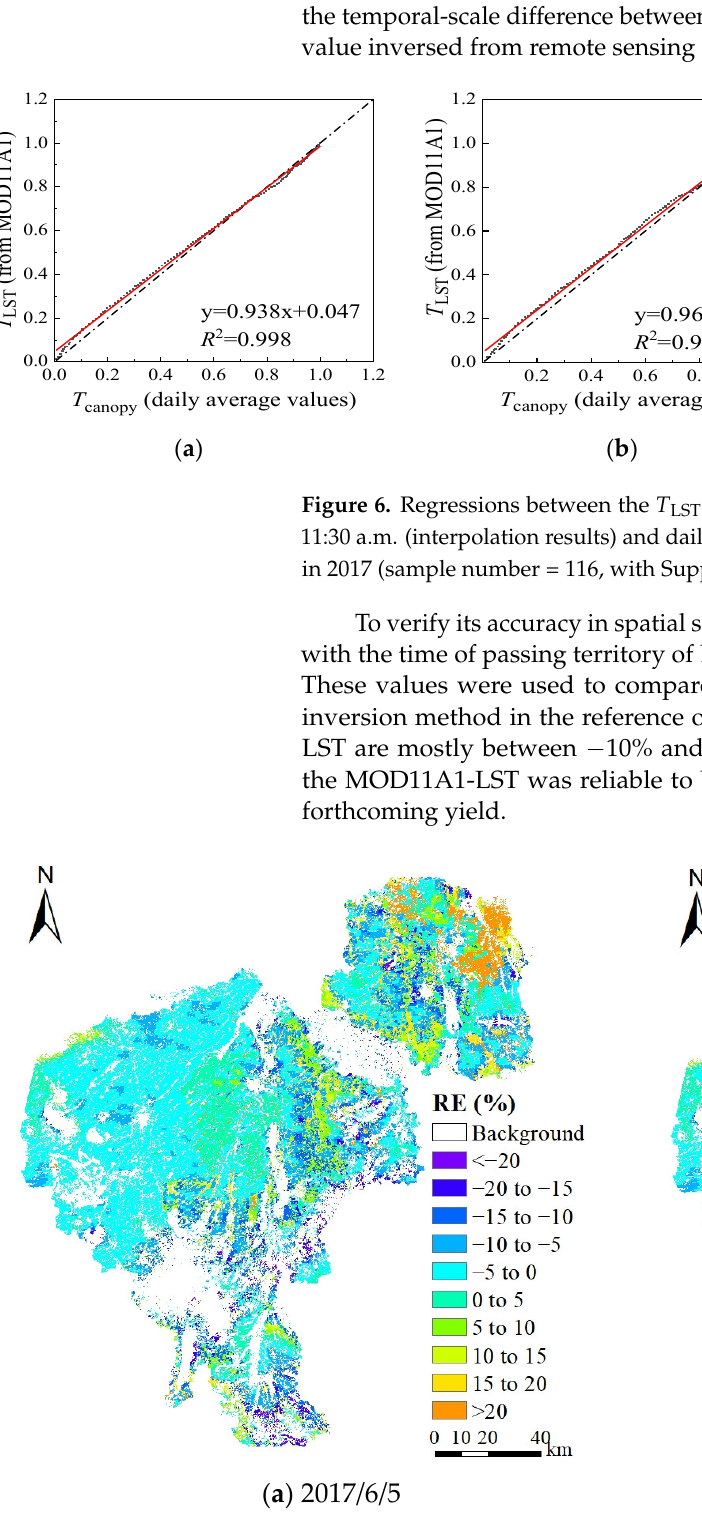
( c ) Figure 5. Regressions between the LST from MOD11A1 product and the observed Tc in field in 2017 (sample number = 58, only at local satellite transit time). ( a ) H1; ( b ) H2; ( c ) H3. As earlier stated, independent variables ( t canopy and T canopy ) in corresponding logistic models are calculated by the daily average value of Tc. However, the retrieved LSTs from MOD11A1 represent instantaneous values in time of passing territory. There is a need to verify the feasibility of instantaneous LST values replacing daily average ones to deter- mine T canop y , when Equation (4) or Equation (6) is used in area. Here, the relative effective accumulated temperature, calculated by instantaneous